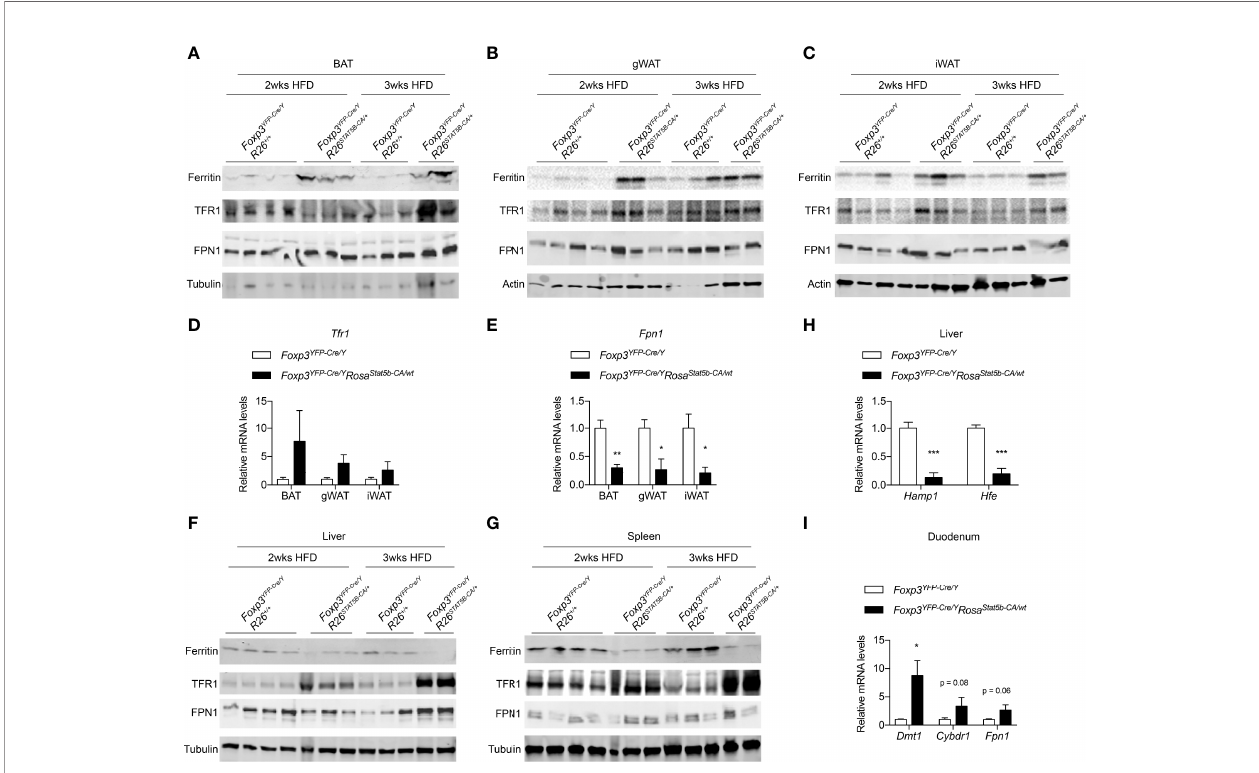
FIGURE 7 | Iron metabolism modulated by Treg cell activation. (A – C) Immunoblotting of Ferritin, TFR1, FPN1 proteins in BAT (A) , gWAT (B) , and iWAT (C) of HFD- fed Foxp3 YFP-Cre/Y and Foxp3 YFP-Cre/Y Rosa26 Stat5b-CA/wt mice. (D, E) Expression of the Tfr1 (D) and Fpn1 (E) genes in adipose tissues of HFD-fed Foxp3 YFP-Cre/Y (n = 7) and Foxp3 YFP-Cre/Y Rosa26 Stat5b-CA/wt (n = 5) mice. (F, G) Immunoblotting of Ferritin, TFR1, FPN1 proteins in liver (F) and spleen (G) of HFD-fed Foxp3 YFP-Cre/Y and Foxp3 YFP-Cre/Y Rosa26 Stat5b-CA/wt mice. (H) Expression of the Hamp1 and Hfe genes in the liver of HFD-fed Foxp3 YFP-Cre/Y (n = 7) and Foxp3 YFP-Cre/Y Rosa26 Stat5b-CA/ wt (n = 5) mice. (I) Expression of the Dmt , Cybdr1 , and Fpn1 genes in the duodenum of HFD-fed Foxp3 YFP-Cre/Y (n = 7) and Foxp3 YFP-Cre/Y Rosa26 Stat5b-CA/wt (n = 5) mice. Data are presented as mean ± SEM. *, p < 0.05; **, p < 0.01; ***, p < 0.001 by unpaired student ’ s